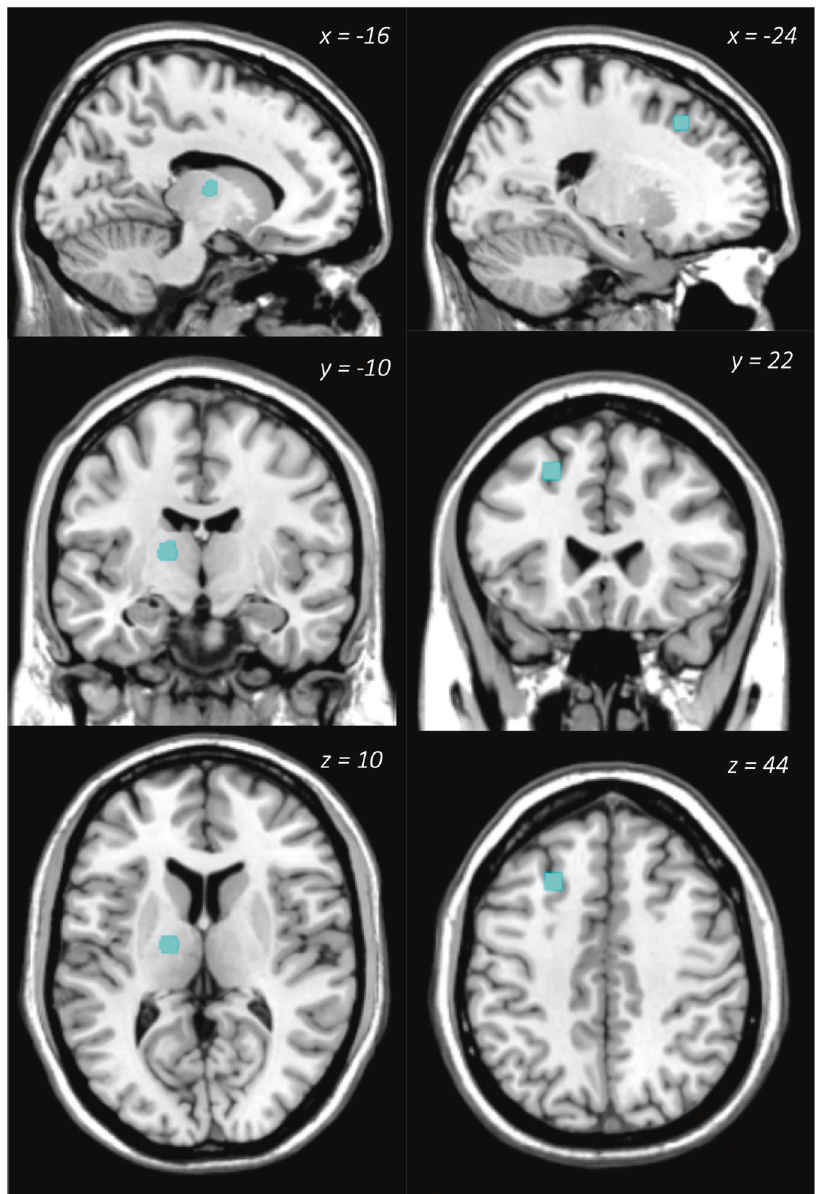
Fig. 3 Neural correlates of depression with concomitant pain. Left superior frontal gyrus/DLPFC and left thalamus signi fi cantly associated with pain scores in depression